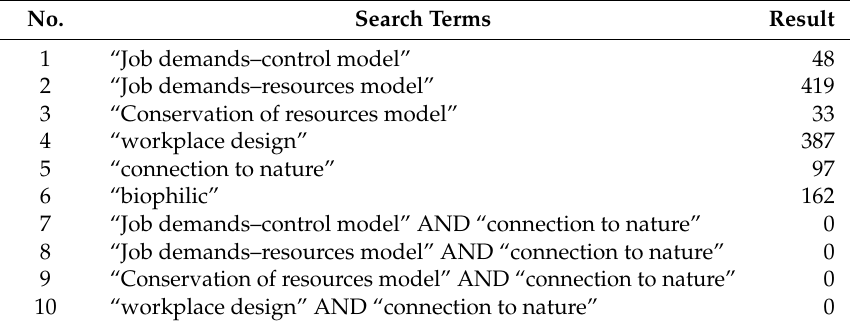
Table 1. Web of Science search